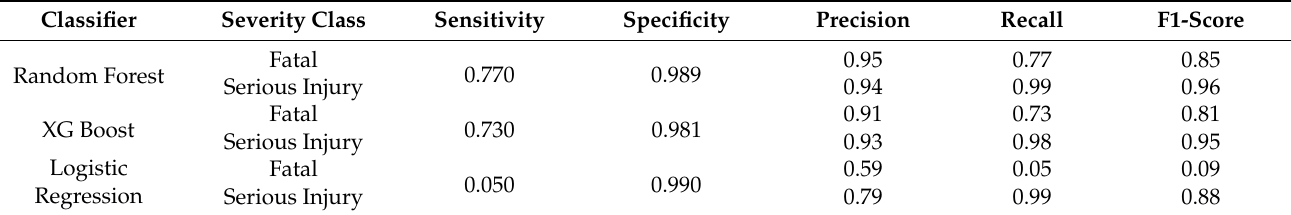
Table 6. Performance metrics for the classifier